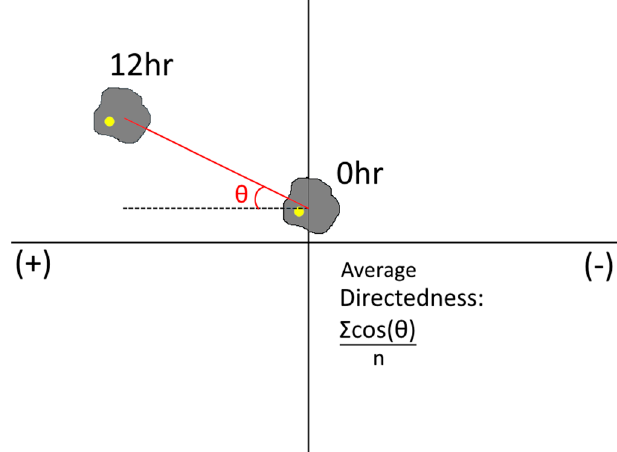
Figure 4. Schematic representation of the angle to calculate directedness.